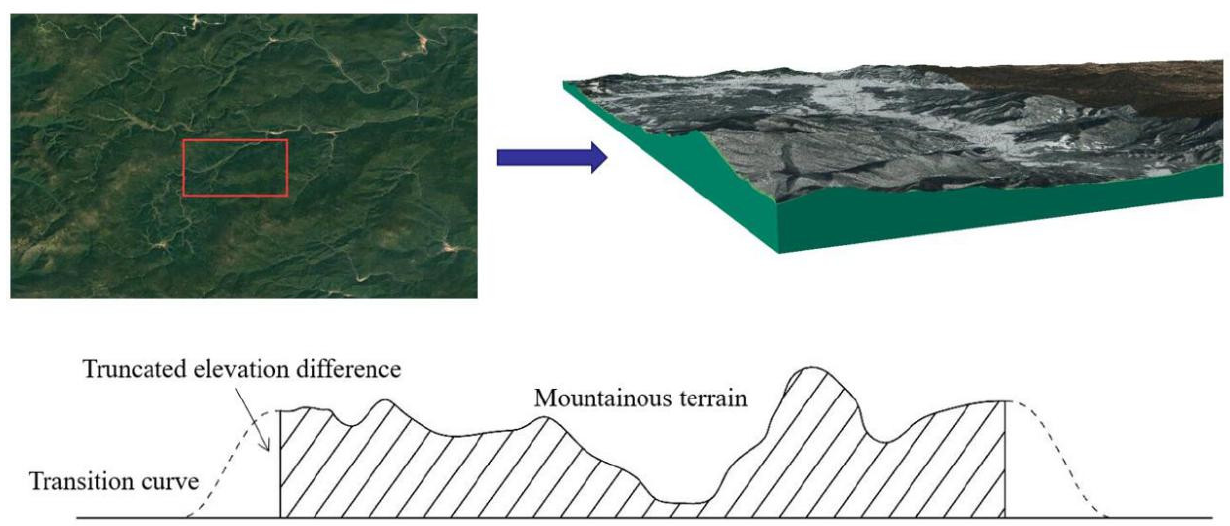
Figure 1. Truncated elevation difference in complex mountainous areas.